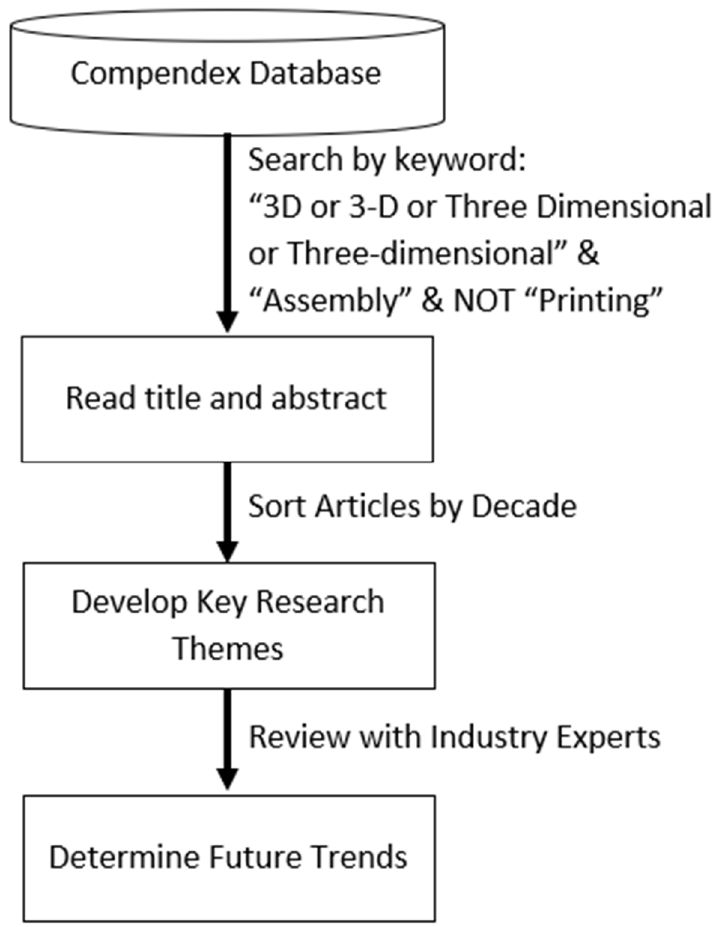
Figure 1. Schematic of research methodology.